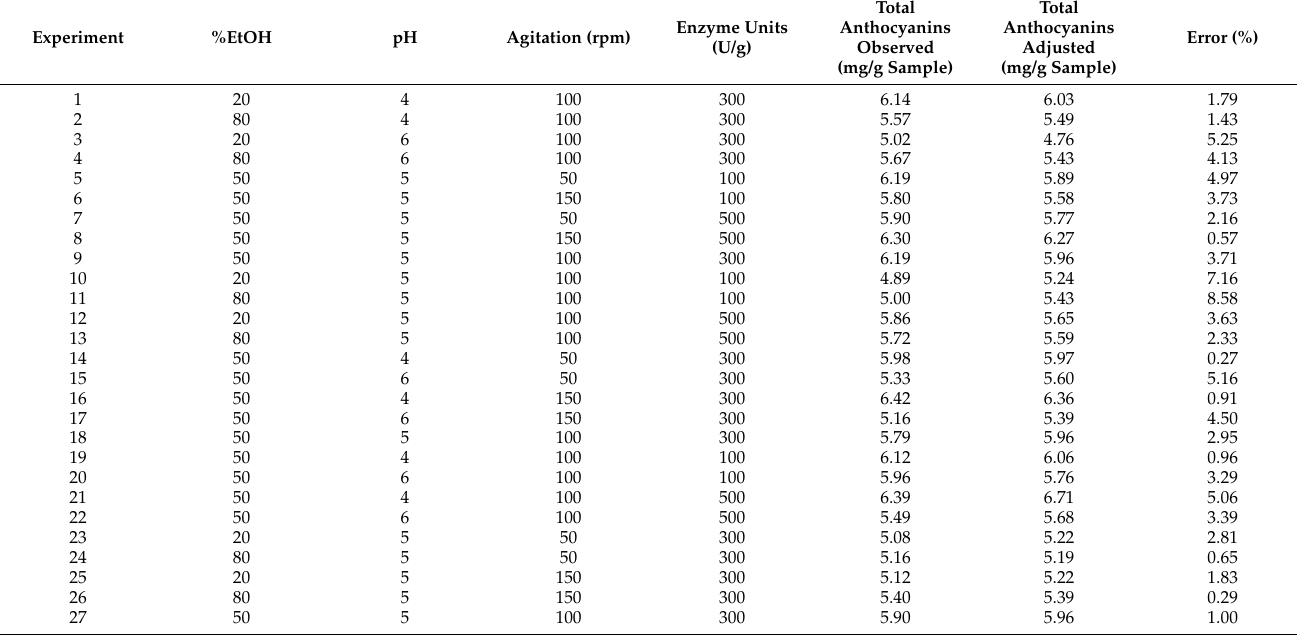
Table 2. Experimental extraction conditions and total anthocyanins obtained and adjusted to the 27 BBD–RSM tests with four